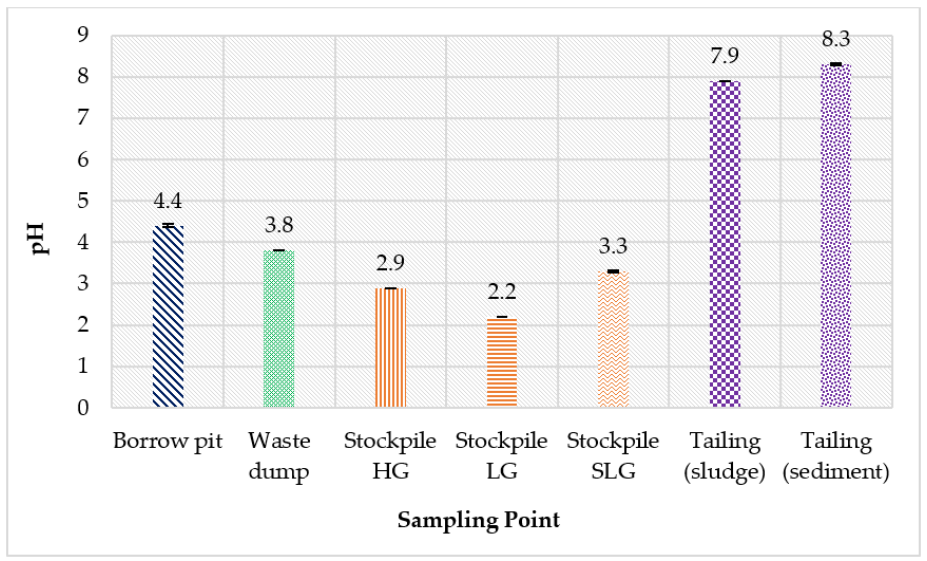
Figure 2. pH of soil, sludge and sediment samples at different types of gold mining waste. Black bars indicate standard deviation from three replicates.